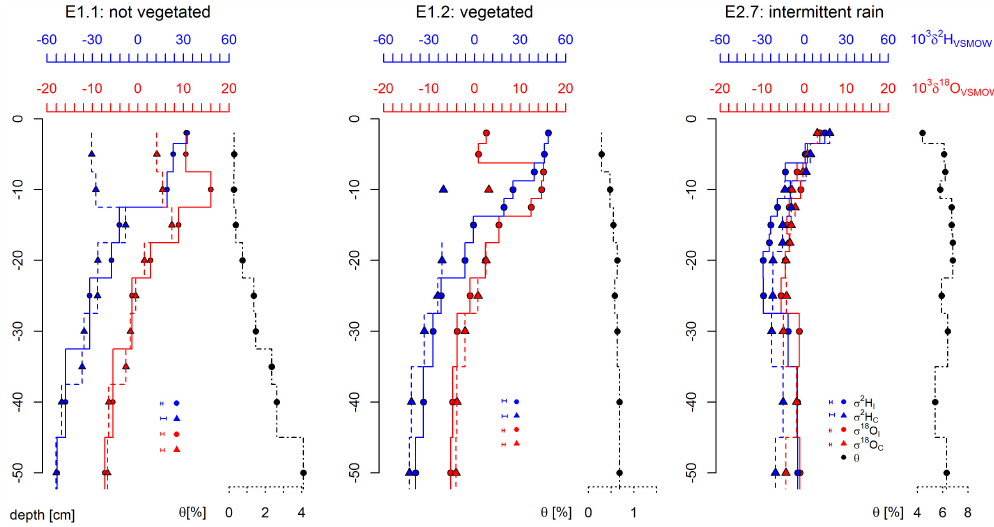
Figure 3. Depths profiles of the field campaign in June 2014 (E1.1, E1.2) and the field campaign in November 2014 (E2.7). Compared are isotope depth profiles extracted with the cryogenic vacuum extraction (dashed lines, triangles) and measured in situ (solid lines, dots). δ 2 H is given in blue and δ 18 O is given in red. Soil moisture is illustrated on the right of each plot (black). Standard deviation for each plot and each method is indicated by error bars in the legend of the plot.